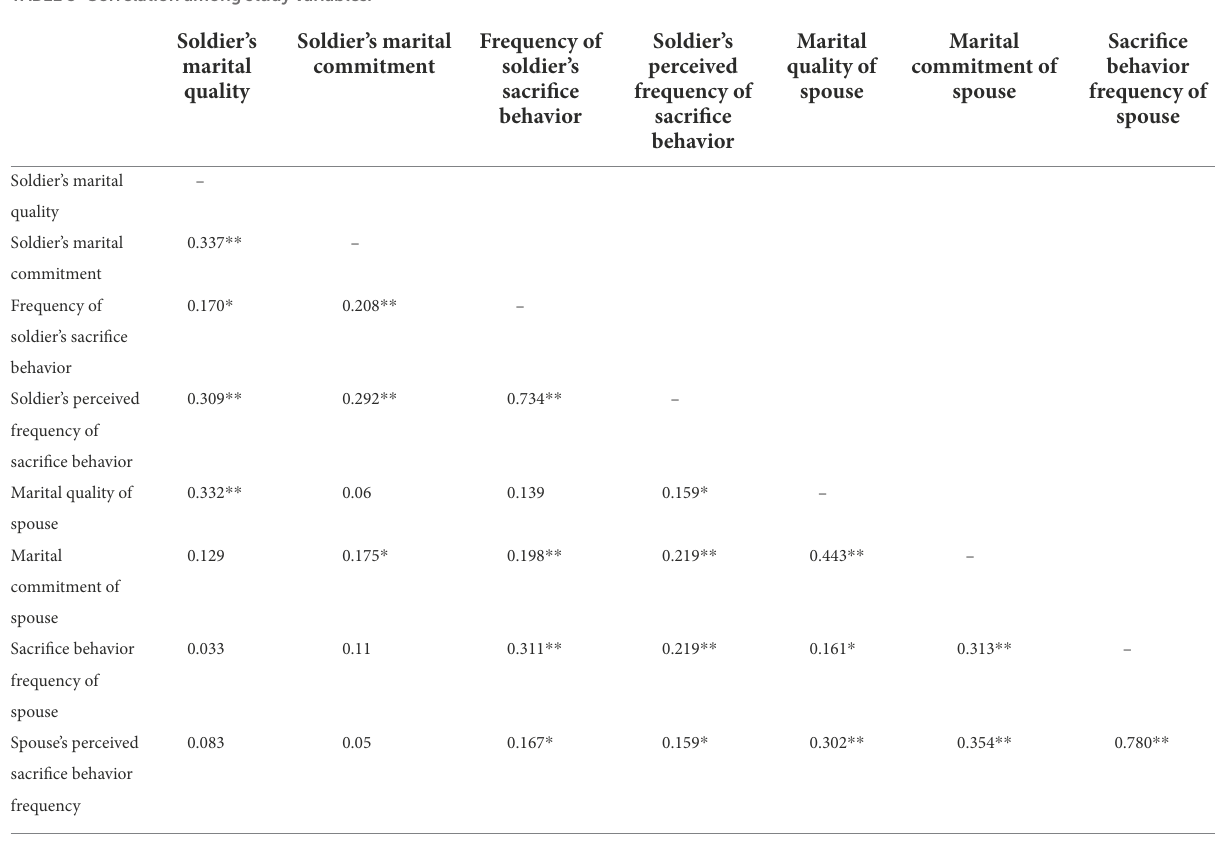
TABLE 3 Correlation among study